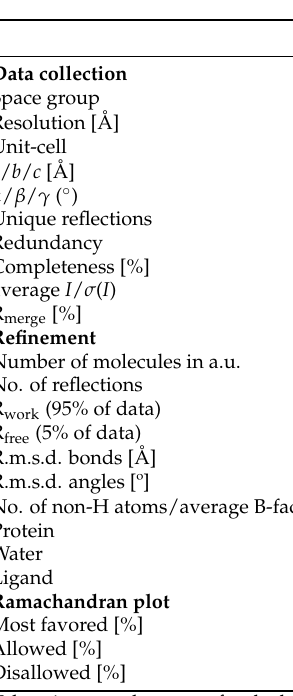
Table 2. Data collection and refinement statistics a